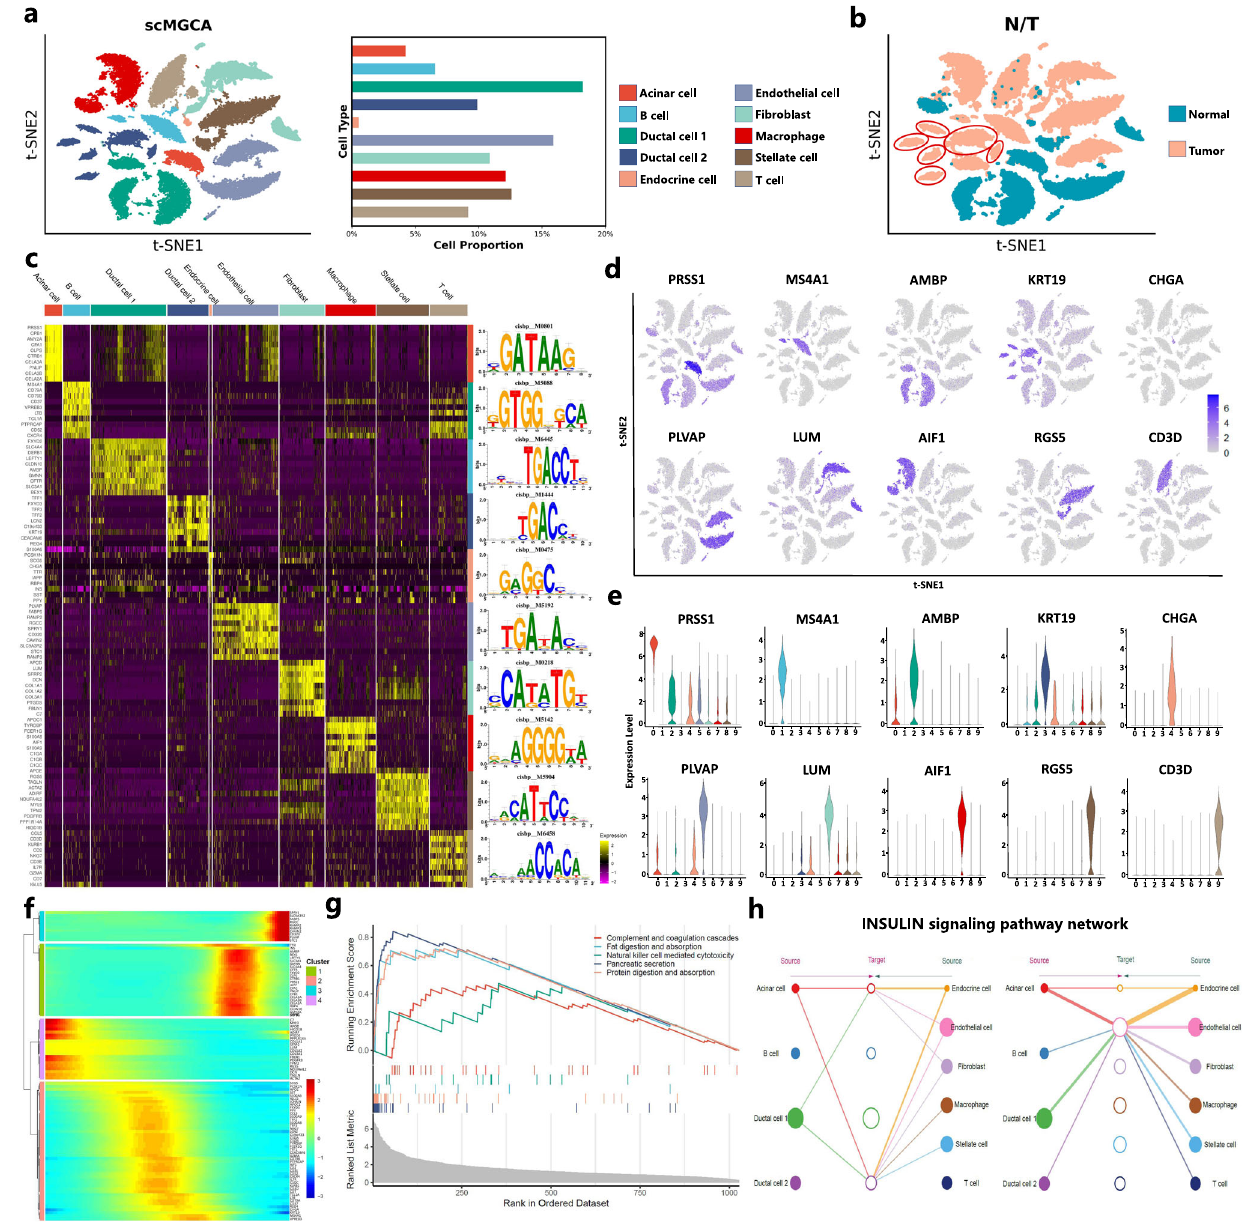
Fig. 7 | PDAC dataset (CRA001160) analysis by scMGCA. a Visualization of cell clusters identi fi ed by scMGCA via t-SNE (left) and the proportion of different cell types (right). b Visualization ofthe distribution ofnormalcells and cancer cells via t-SNE. c Heatmapof top10marker gene expressionlevels foreachcellcluster,and the corresponding DNA binding motif for each cell cluster. d Visualization of